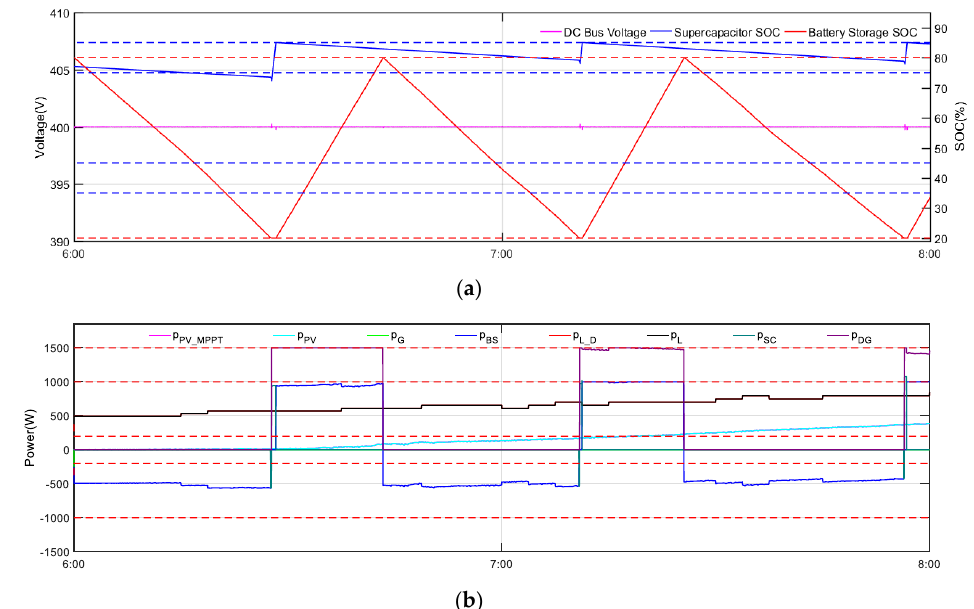
Figure 10. Curves of common DC Bus voltage and SOC of storage ( a ) and curves of power ( b ) during the period 6:00–8:00.